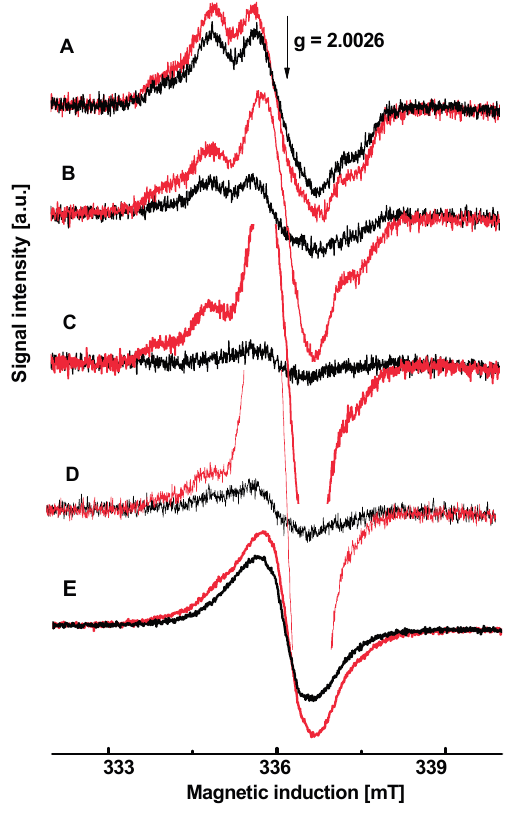
Figure 3. EPR spectra of untreated spinach chloroplasts ( A ) and those treated with 0.05 mol/dm 3 of 2a ( B ); 2b ( C ); 3e ( D ) and 4f ( E ). Black curves indicate spectra registered in the dark. Red curves indicate spectra registered in the